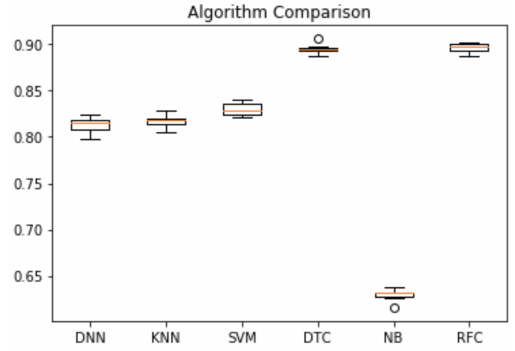
Figure 5. Algorithm comparison using cross-validation